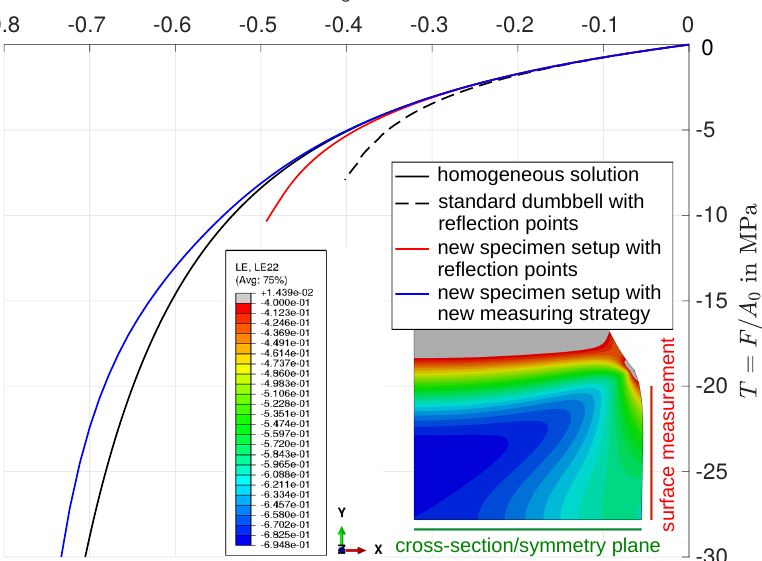
Figure 3. Stress–strain diagram for the standard dumbbell and the new specimen setup, FE-simulation with evaluation (figure based on [19] with small